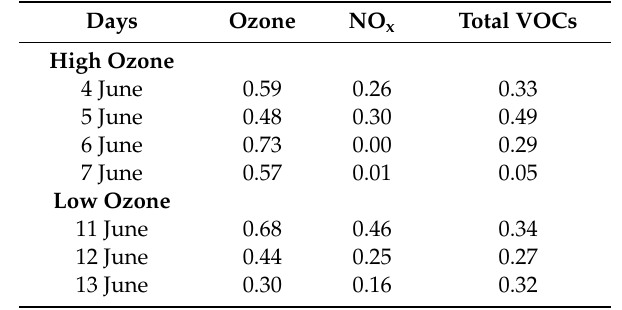
Table 5. The correlation coe ffi cient (R) between the modeled PBLH (using WRF) and ozone concentrations and its precursors during the high and low ozone days.